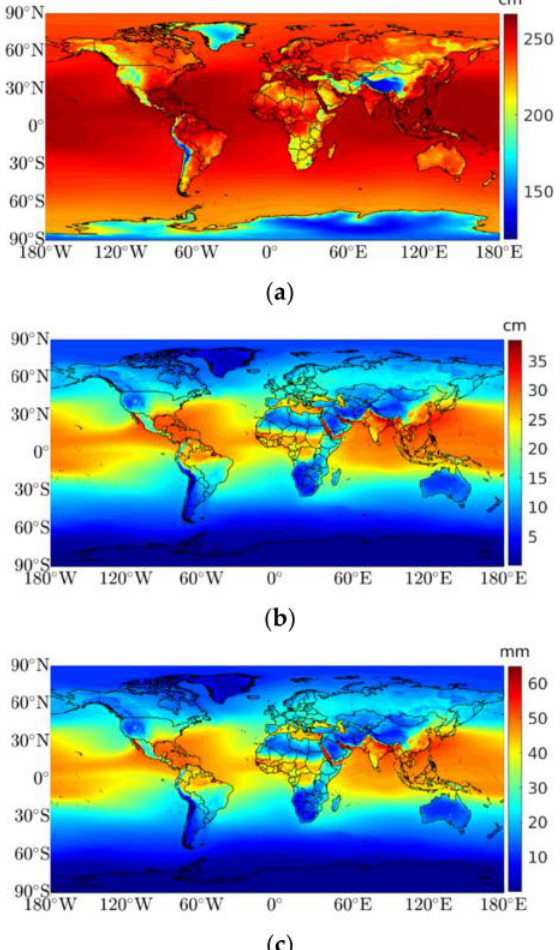
Figure 4. Example of ZTD, ZWD, and PWV maps calculated on August 1, 2020, 12:00 UTC: ( a ) ZTD obtained from the sum of the two components (ZHD and ZWD), in cm; ( b ) ZWD obtained using the Saastamoinen wet model (see Equation (8)), in cm; and ( c ) PWV calculated using the ZWD and a constant of proportionality ( Π , second term of Equation (9)), in